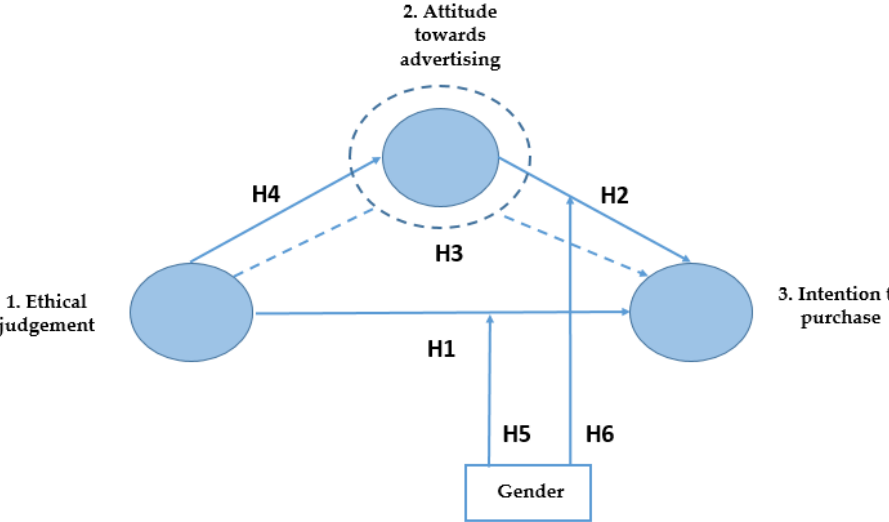
Figure 1. Research Model (videos 1 and 2). H means hypothesis. Source: Own